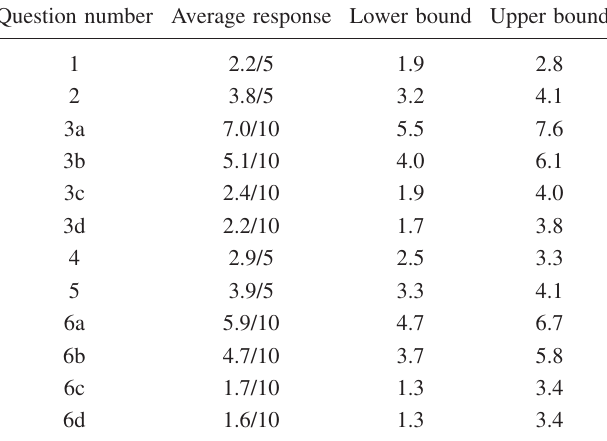
TABLE II. Results from end-of-year survey